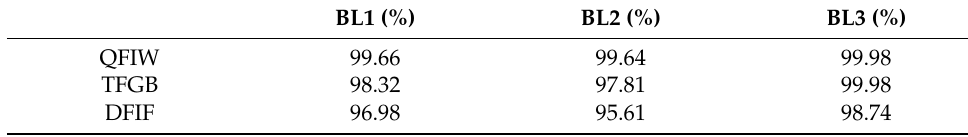
Table 4. Statistics of basic ambiguity resolution success rate.